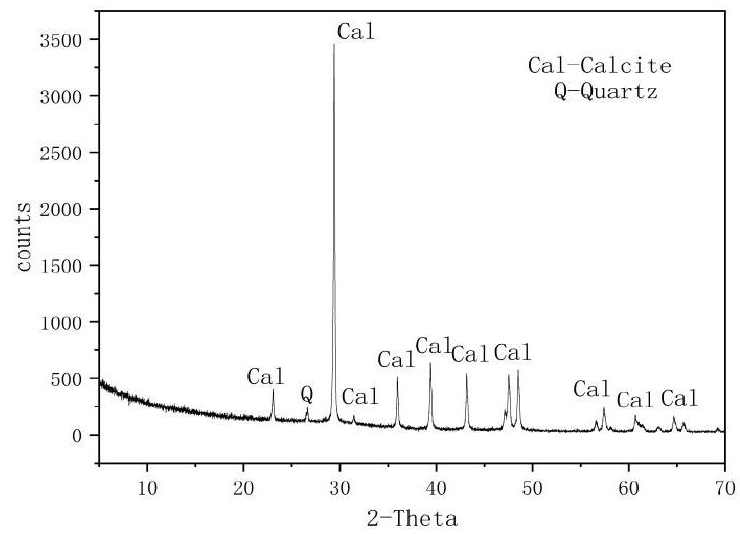
Figure 1. Supplementary figure of the X-ray diffraction whole-rock mineral analysis [7]. Table 2 lists the chemical makeup of samples obtained from X-ray fluorescence spec-